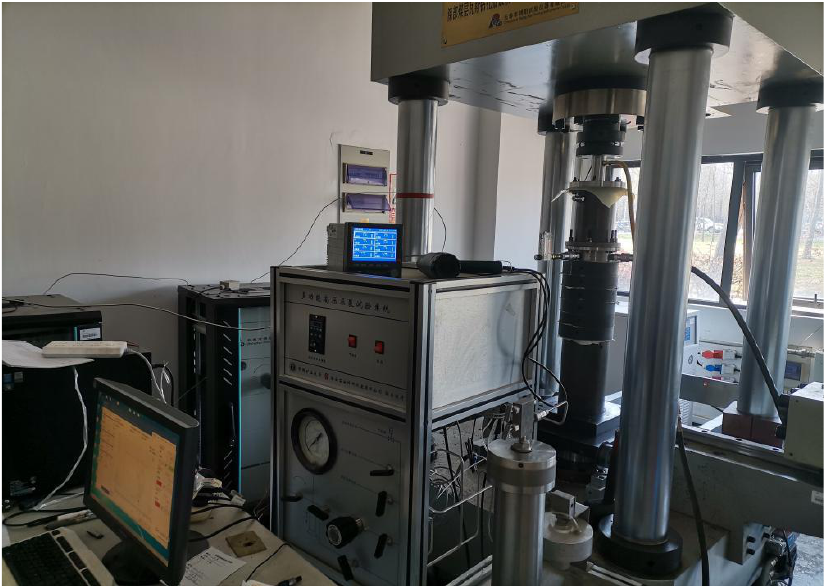
Figure 2. The TAWD-2000 Coal and Rock Mechanics – Permeability Test System.